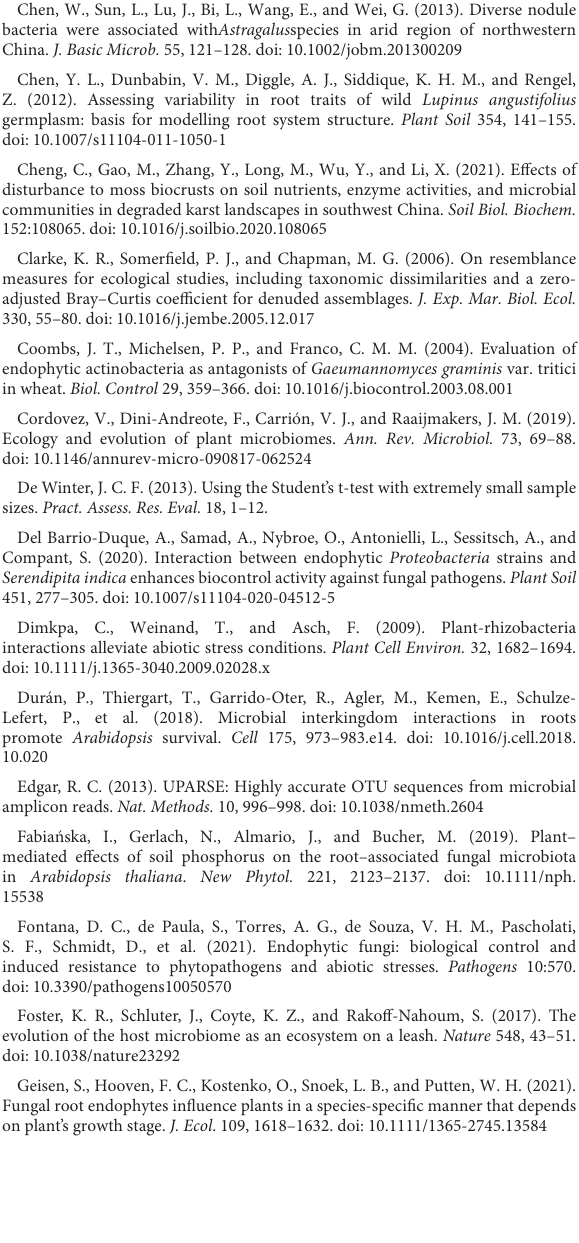
SUPPLEMENTARYFIGURE4 Clustering heatmap depicting the occurrences of relatively abundant (top 50 abundance) fungal operational taxonomic units (OTUs). The color of each heat map cell indicates the relative abundance of the corresponding fungal OTUs. Cluster analysis was performed based on Bray–Curtis similarities. C, non-inoculated control; A, inoculation with Alternaria chlamydospora ; S, inoculation with Sarocladium kiliense ; M, inoculation with Monosporascus sp.; AS, co-inoculation of Alternaria chlamydospora and Sarocladium kiliense ; AM, co-inoculation of Alternaria chlamydospora and Monosporascus sp.; SM, co-inoculation